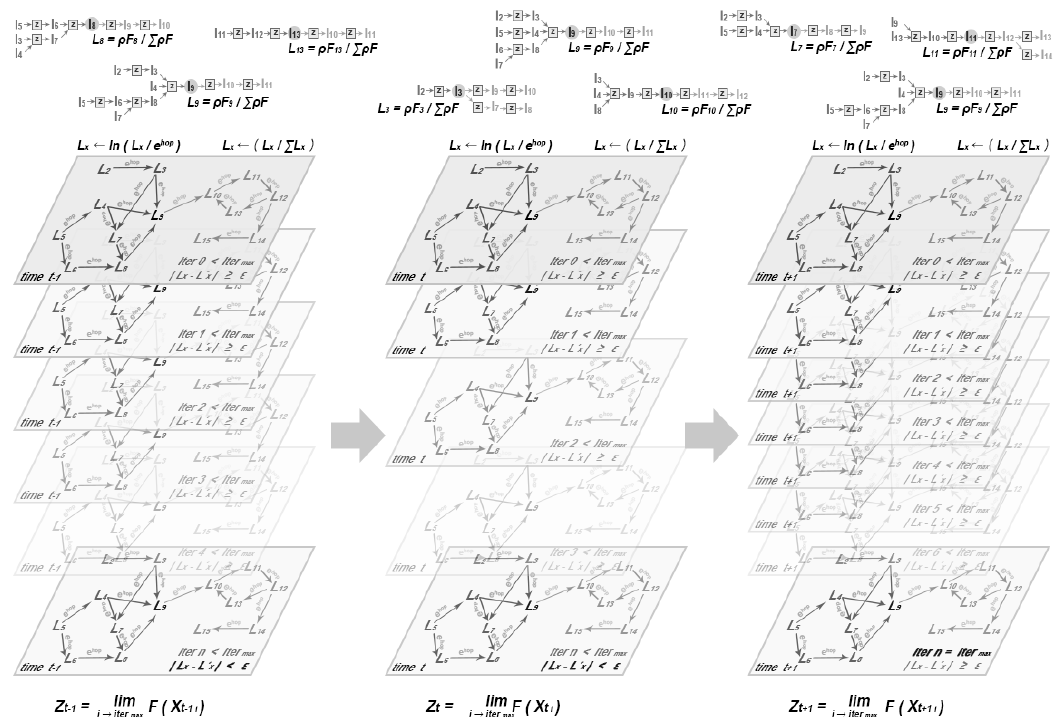
Figure 7. Iterative computation of traffic flow centrality for every link in the traffic